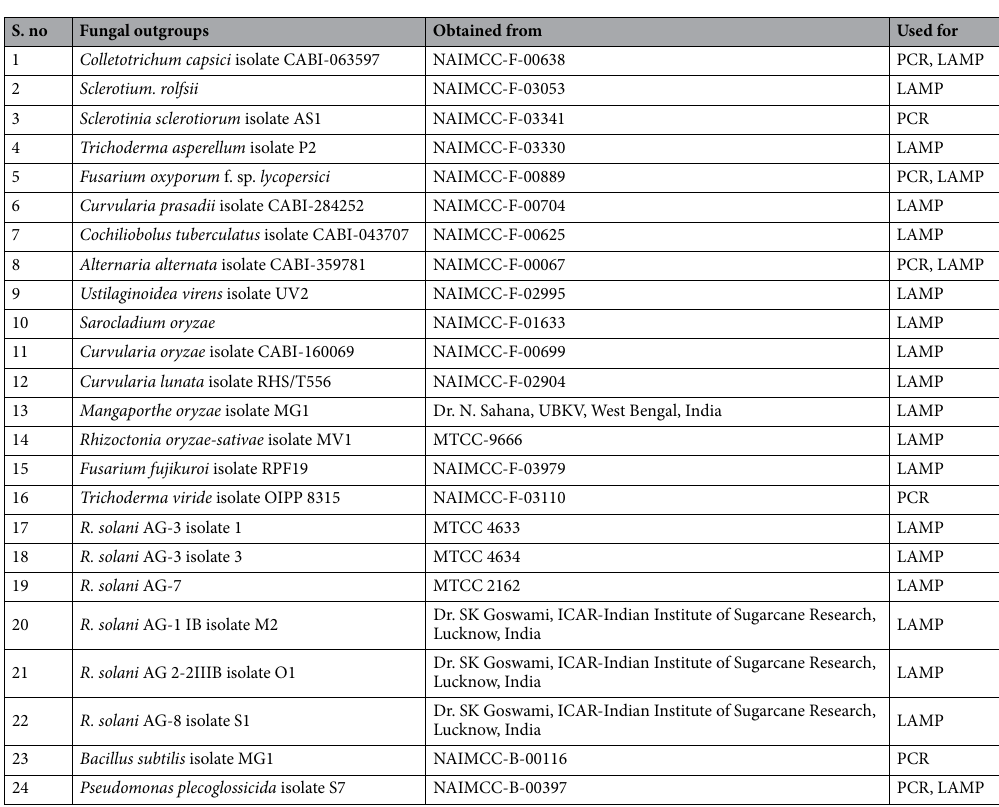
Table 3. Various bacterial and fungal cultures used as references for assay